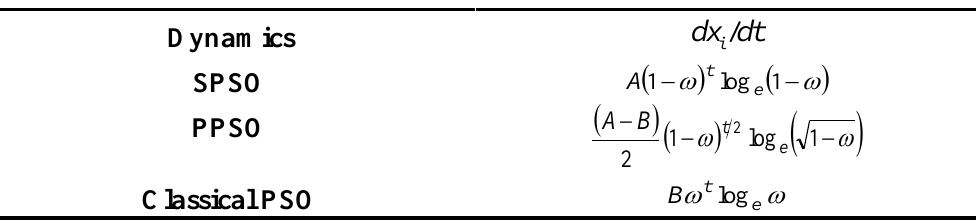
Table 3. / dx dt for SPSO, PPSO and classical PSO. i